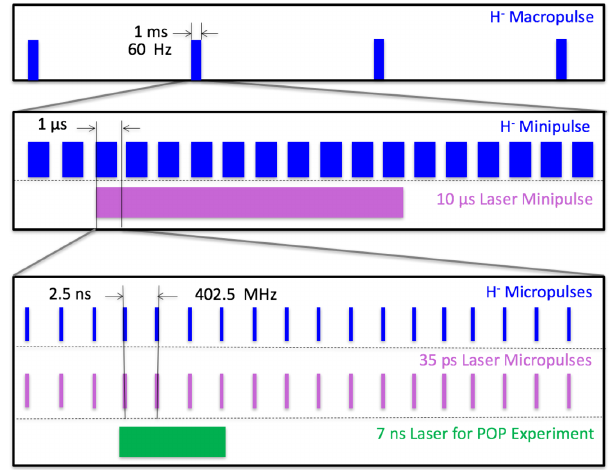
FIG. 2. The macropulse (top), minipulse (middle), and micro- pulse (bottom) structure of the SNS H − beam (blue), the laser in this 10 μ s experiment (light purple), and the laser in the POP experiment (green). This figure is reproduced from Ref. [7].